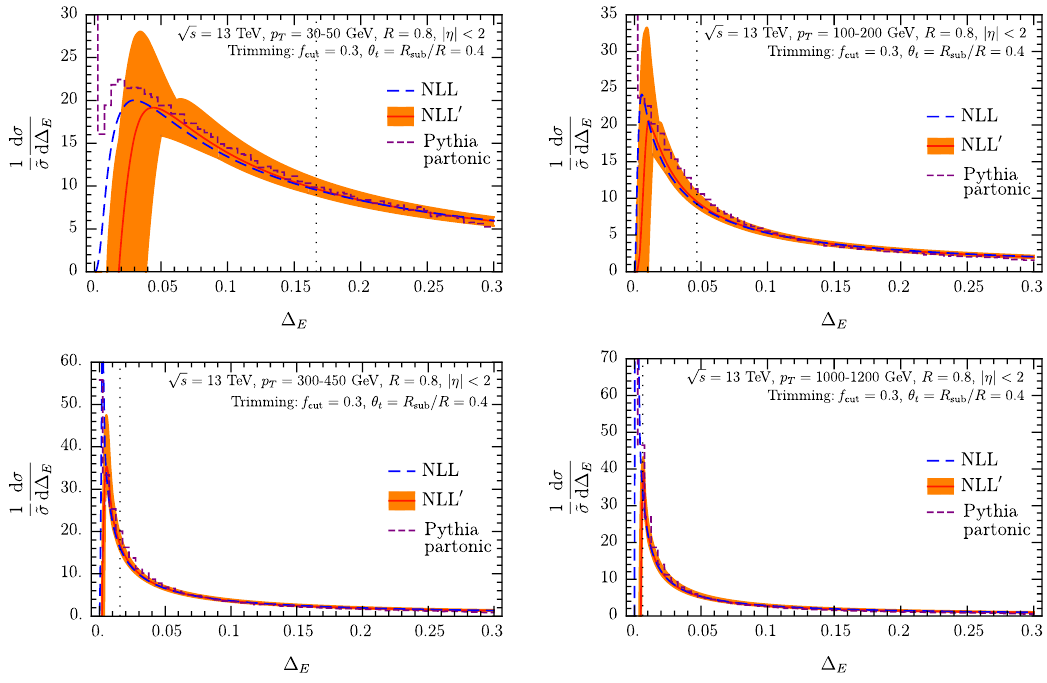
Figure 24 . Numerical results for the jet energy drop obtained with the trimming algorithm at NLL (blue dashed) and NLL 0 (orange) order, compared to Pythia partonic (purple dashed). We choose trimming parameters f cut = 0 . 3 and θ t = 0 . 4 . The different panels correspond to different jet transverse momenta. The central curves are normalized to unity between the dotted vertical line and ∆ E = f cut